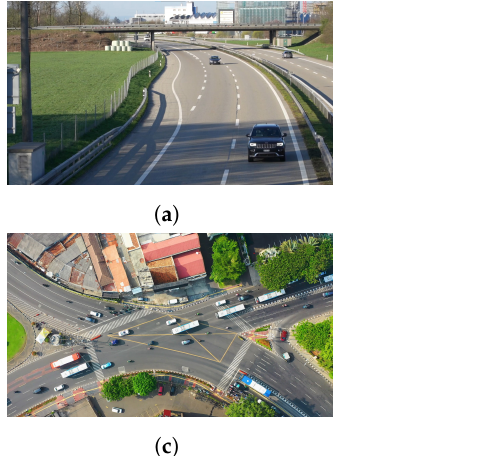
Figure 3. Candidate situations. ( a ) View above the road level; ( b ) bird’s eye view from the side; ( c ) bird’s eye view; ( d ) road level view. Source of the input video: